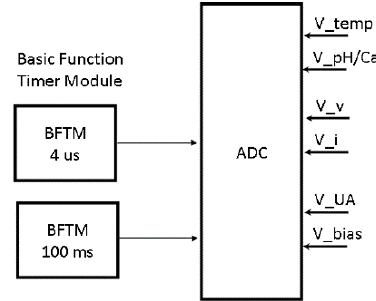
Figure 11. Digital system analog-to-digital converter (ADC) module connections.